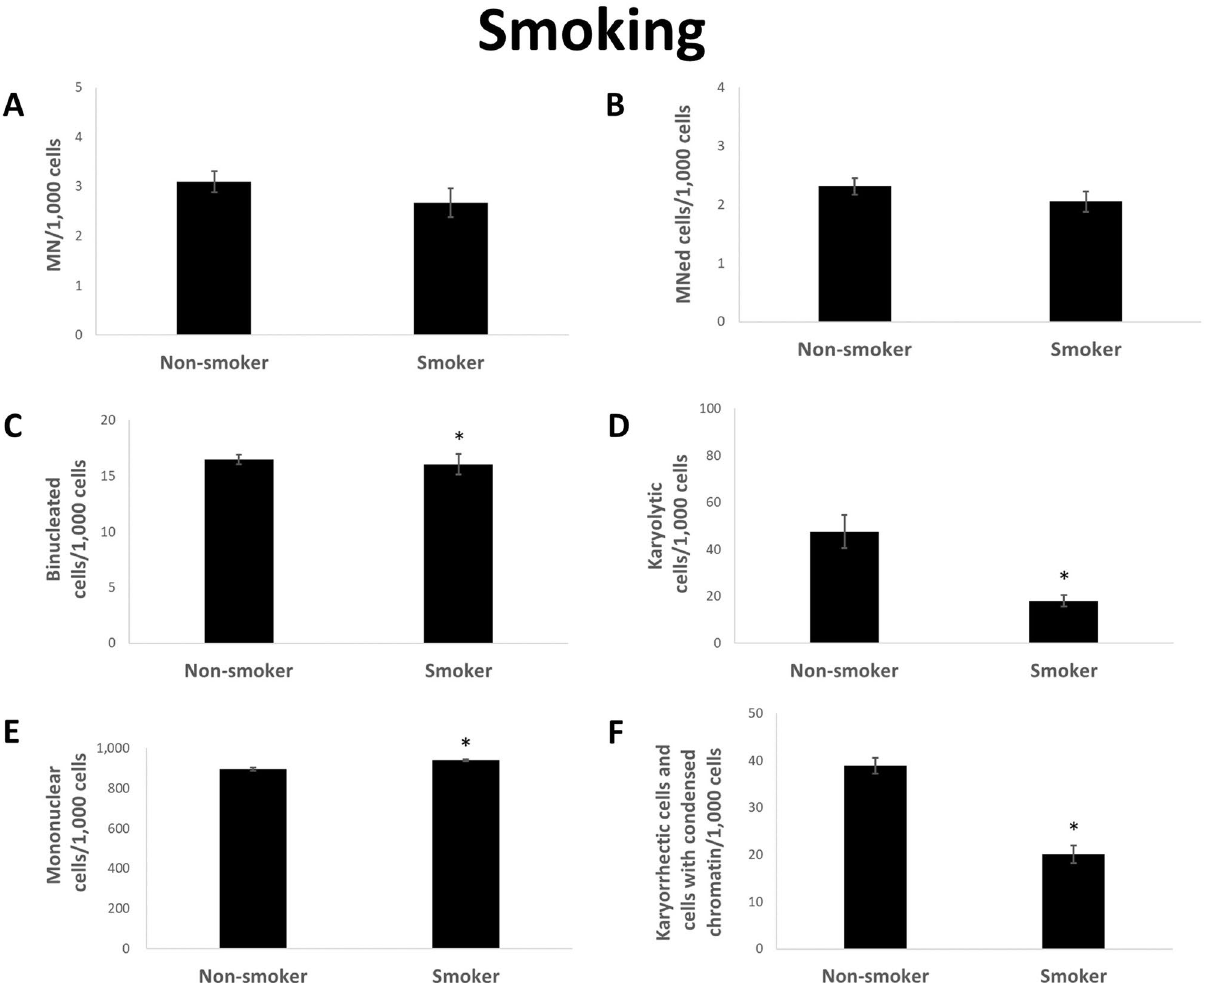
Figure 3. Rate of MN ( A ), MNed cells ( B ), binucleated cells ( C ), karyolytic ( D ), mononuclear ( E ) and karyorrhectic cells and cells with condensed chromatin ( F ) per 1000 cells from reference distributed by smoking habit. Mean of each group ± standard error. n (non-smoker): 251; n (smoker): 77. Asterisk represent p value < 0.05 after statistical evaluation referring to non-smoker